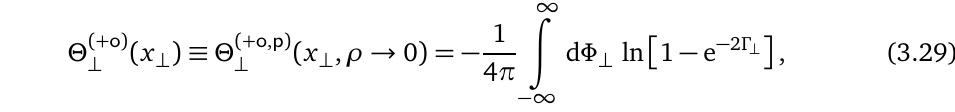
Figure 14: Surface free energy density of a staggered field f dashed line marks criticality for arbitrary anisotropy κ = K ⊥ / K . For fixed anisotropy the two couplings are connected by t = ( z ∗ ) κ and the black lines mark the run of the related curves, where the isotropic case is shown in red. Note that we have (cid:112) = 3 / 2 as it has a maximal value of ln2. For z chosen z st logarithmically for t →